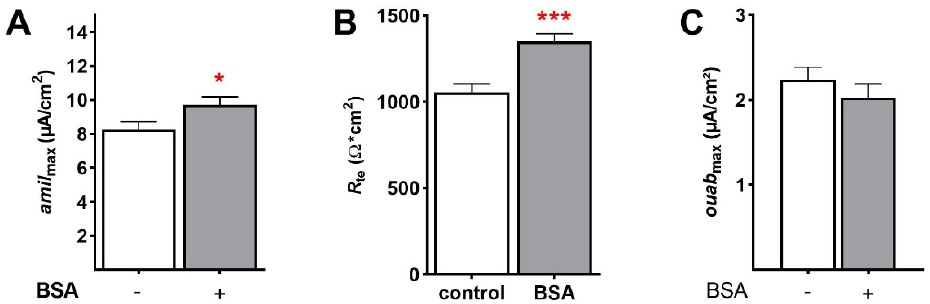
Figure 5. BSA increases maximal ENaC activity after 45 min, but not that of the Na,K-ATPase. FDLE cells were cultured in MEM and stimulated with BSA (1.0 g/L) for 45 min. Data are displayed as mean + SEM. BSA significantly increased ( A ) amil max and ( B ) R te (n = 39–42; * p < 0.05; *** p < 0.001 by t -test). ( C ) In contrast, BSA had no effect on maximal Na,K-ATPase activity ( ouab max ) after 45 min (n = 27–31).